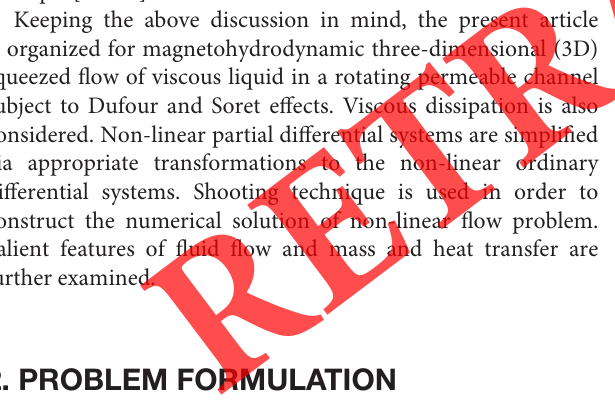
FIGURE 1 | Schematic diagram of the problem.